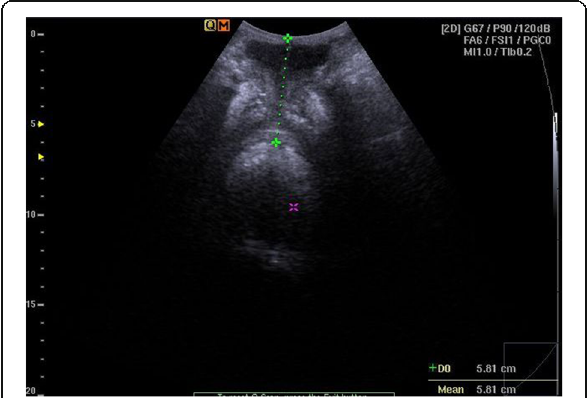
Fig. 4 Fetal head perineum distance (2). HPD is 5.81 cm rounded up